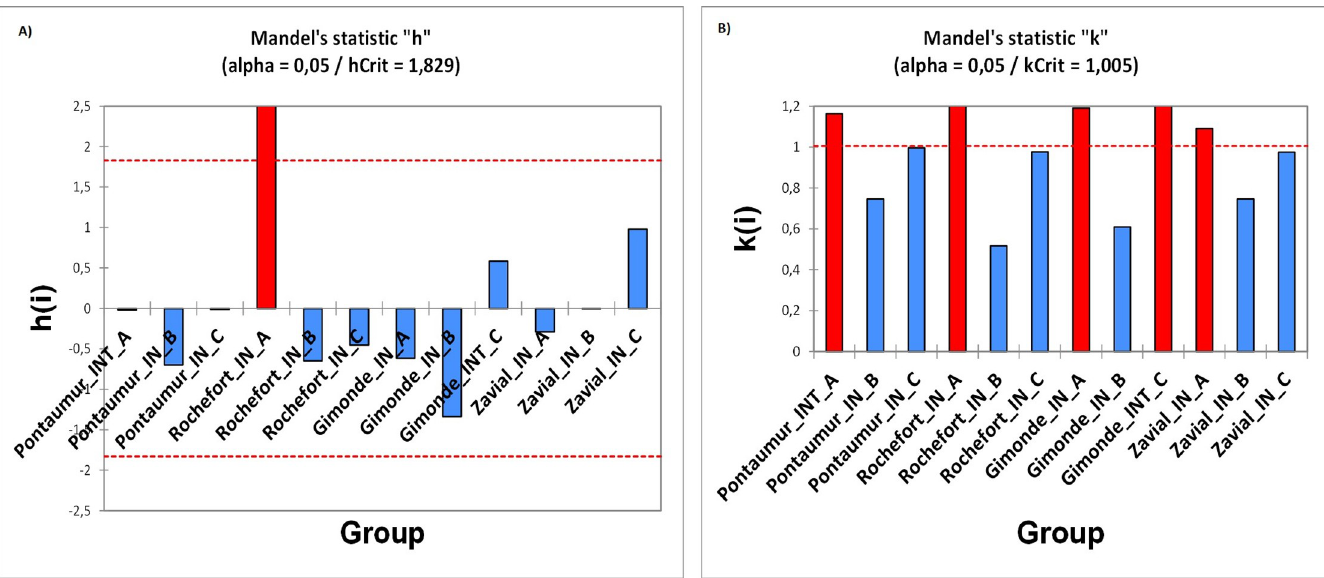
Fig 6. Mandel’s graphs showing results of statistical analysis on homogeneity of means (A) and variances (B) of RH measured in hives of the four conservation centers over a complete year for each iButton (A, B, C).